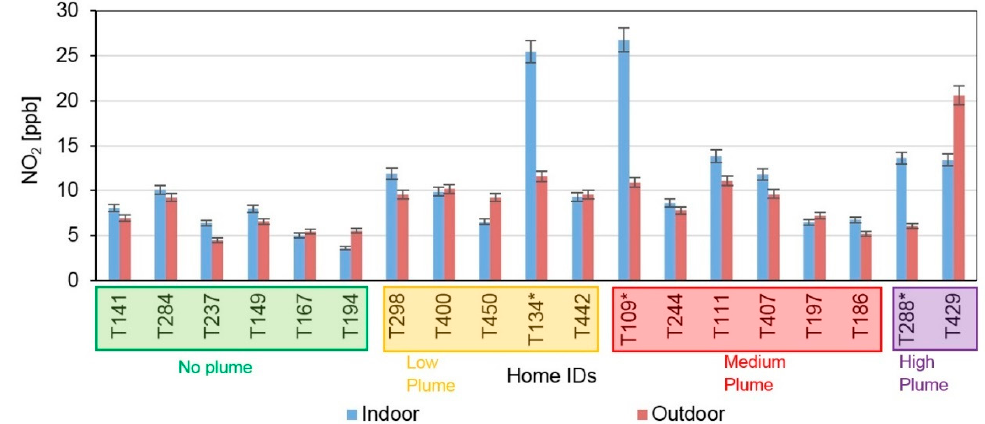
Figure 7. NO 2 concentrations measured in 2017 in all homes ( n = 19). Home IDs with asterisk represent homes with gas stoves. Error bars indicate sampler uncertainty. Homes are ordered from left to right with increasing wildfire plume densities during sampling.